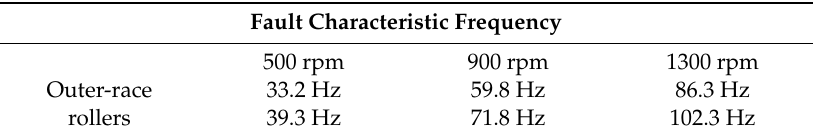
Table 1. Fault characteristic frequencies of rolling bearing at different